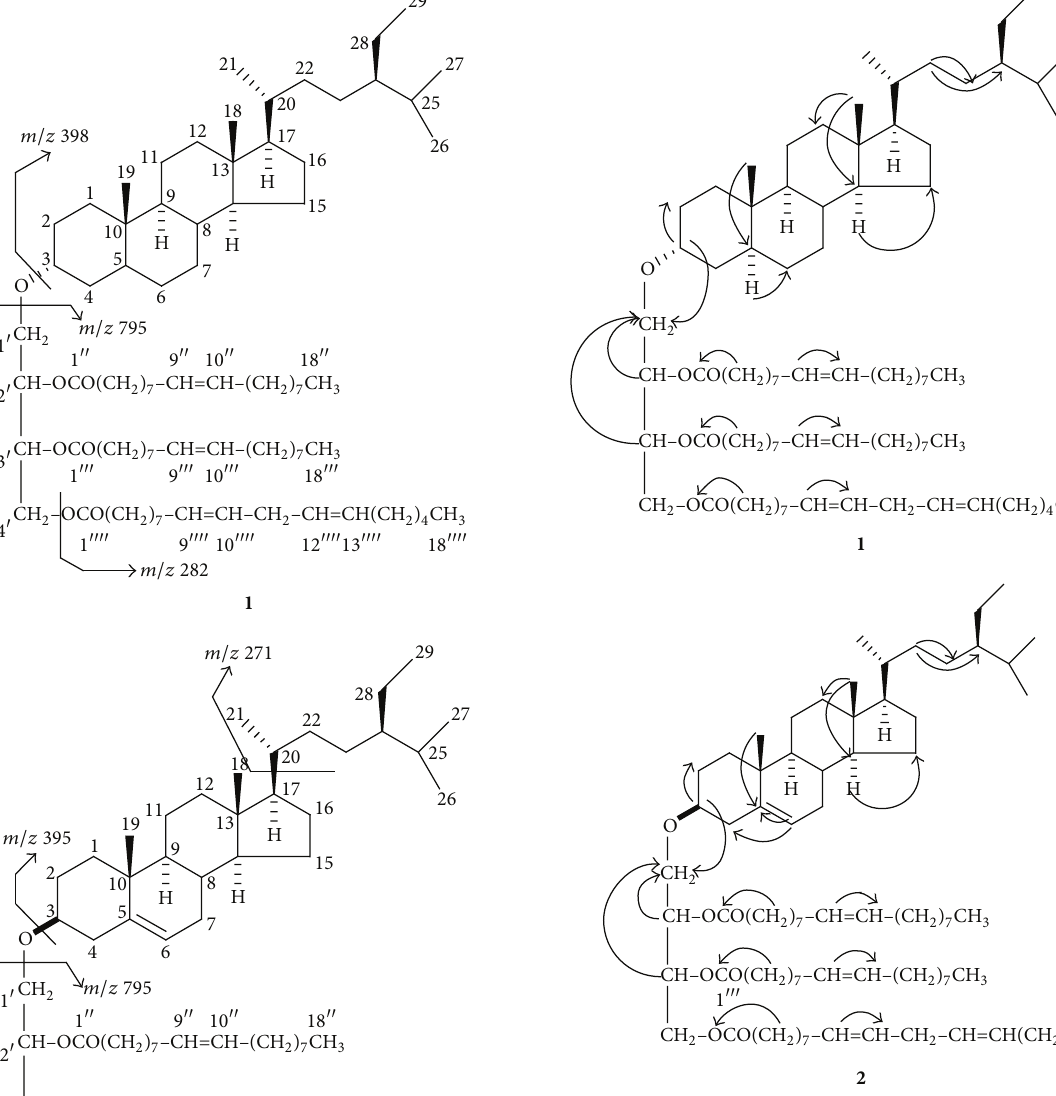
The 1 H- 1 H COSY spectrum of 2 showed correlations of H-3 with H 2 -2 and H 2 -4; H-6 with H 2 -4, H 2 -7, and H-8; H-2 󸀠 with H 2 -1 󸀠 , H-3 󸀠 , and H 2 -4 󸀠 ; and H 2 -11 󸀠󸀠󸀠󸀠 with H-9 󸀠󸀠󸀠󸀠 , H-10 󸀠󸀠󸀠󸀠 , H-12 󸀠󸀠󸀠 , and H-13 󸀠󸀠󸀠󸀠 . The key HMBC correlations of 2 that exhibited interactions of proton carbon relations are shown in Figure 3. The HSQC spectrum of 2 showed correlations of H-3 at 𝛿 3.51 with C-3 at 𝛿 71.22; H 2 -1 󸀠 at 𝛿 5.02 with C-2 󸀠 at 𝛿 68.19; H 2 -1 󸀠 at 𝛿 4.30 with C-1 󸀠 at 𝛿 61.36; H-3 󸀠 at 𝛿 4.13 with C-3 󸀠 at 𝛿 65.01, and H 2 -4 󸀠 at 𝛿 3.72 and 3.51 with C-4 󸀠 at 𝛿 62.07. Alkaline hydrolysis of 2 yielded 𝛽 -sitosterol, oleic and linoleic acids, TLC comparable. These lines of evidence led to the formulation of the structure of 2 as stigmasta-5-en-3 𝛽 -ol-3 𝛽 - 󸀠 󸀠 󸀠 󸀠 󸀠 󸀠 󸀠 󸀠 󸀠󸀠 󸀠󸀠󸀠 R ,3 S )-butane-1 ,2 ,3 ,4 -tetraolyl-2 ,3 -dioctadec-9 /9 - (2 󸀠 󸀠󸀠󸀠󸀠 󸀠󸀠󸀠󸀠 -octadec-9 ,12 -dienoate ( 2 , Figure 2). This is a enoyl-4 new steroidal erythrityl